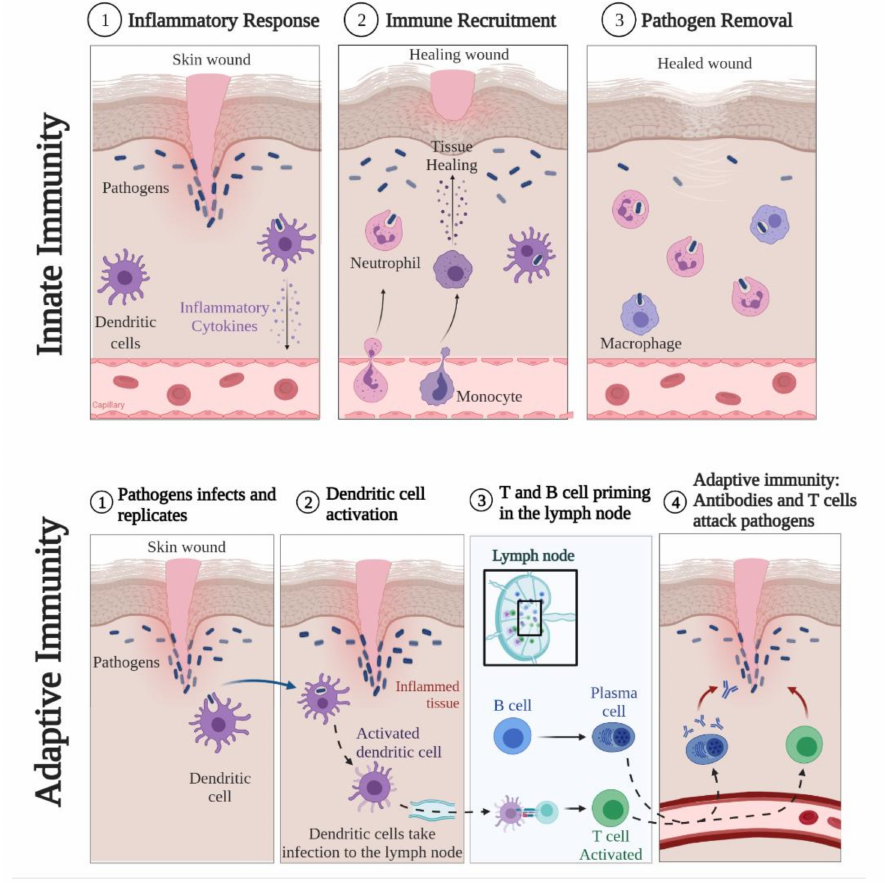
Figure 3. The general inflammatory process of the